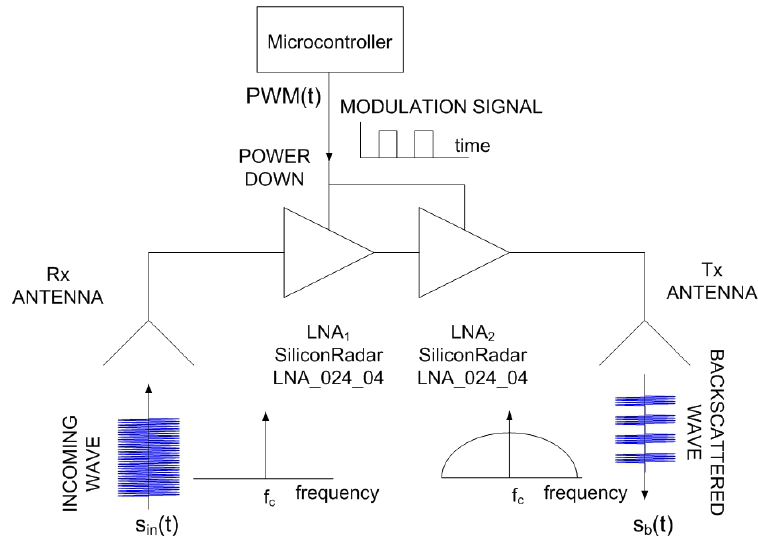
Figure 4. Block diagram of the tag designed as a proof of